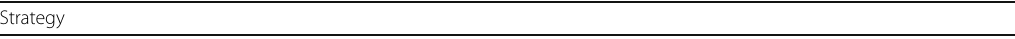
Table 1. Searches were performed until March 20,